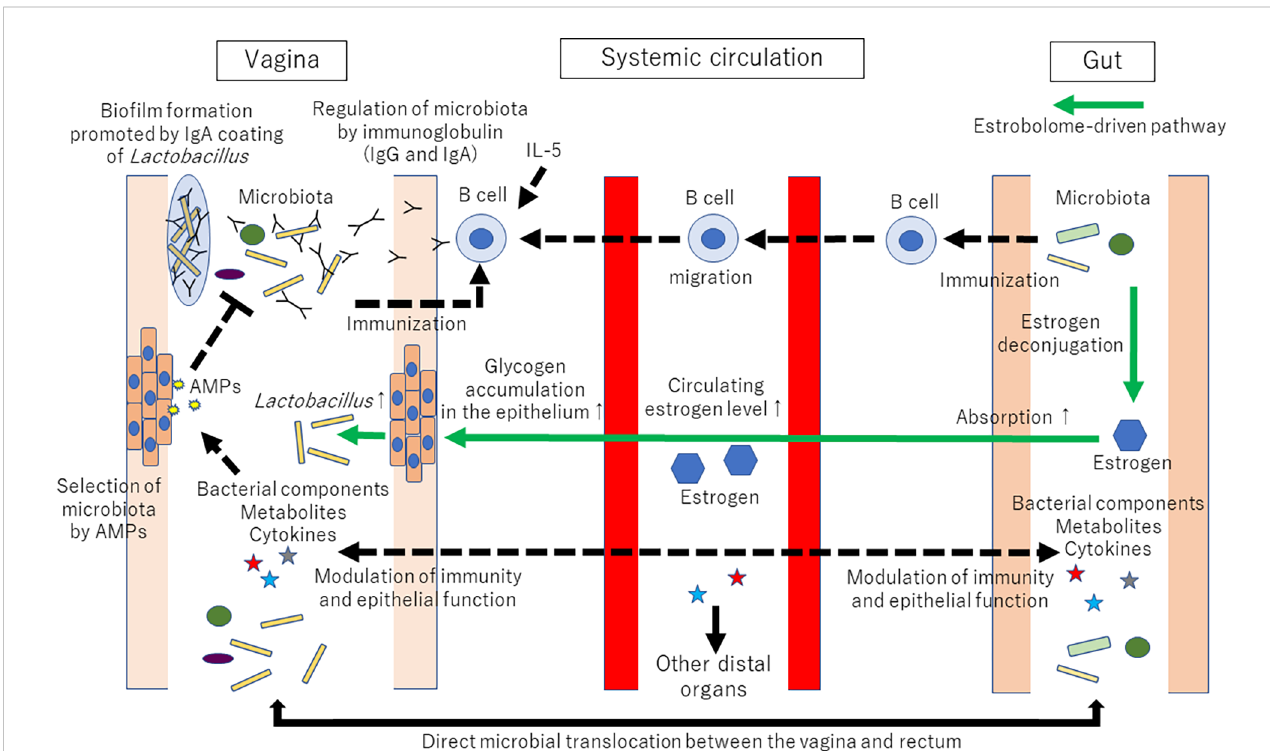
FIGURE 2 Proposed mechanisms of vaginal microbiota shaping via the vagina-gut axis. Many factors, such as age, ethnicity, menstrual cycle, lifestyle, immune system, infection, and probiotics, are known to affect the composition of the vaginal microbiota. However, why the human vaginal microbiota is often dominated by a single or a few strains of Lactobacillus is still unknown. Tolerance and promotion of Lactobacillus dominance in the vagina might be regulated via the vagina-gut axis. Immunization with Lactobacillus might occur both in the vagina and the gut. The collection of microorganisms that can metabolize estrogens (coined the estrobolome) can deconjugate hepatically conjugated estrogens in the gastrointestinal tract. Deconjugated estrogen is then reabsorbed to the systemic circulation. Circulating estrogen will affect the distal epithelia of the vagina, resulting in glycogen and mucus production. Then, increased glycogen supports Lactobacillus dominance in the vagina because glycogen can serve as an energy source for lactobacilli. AMPs: antimicrobial peptides and proteins. The established pathways are represented by solid lines. The proposed mechanisms are represented by dotted lines. The estrobolome-driven pathway is represented by green